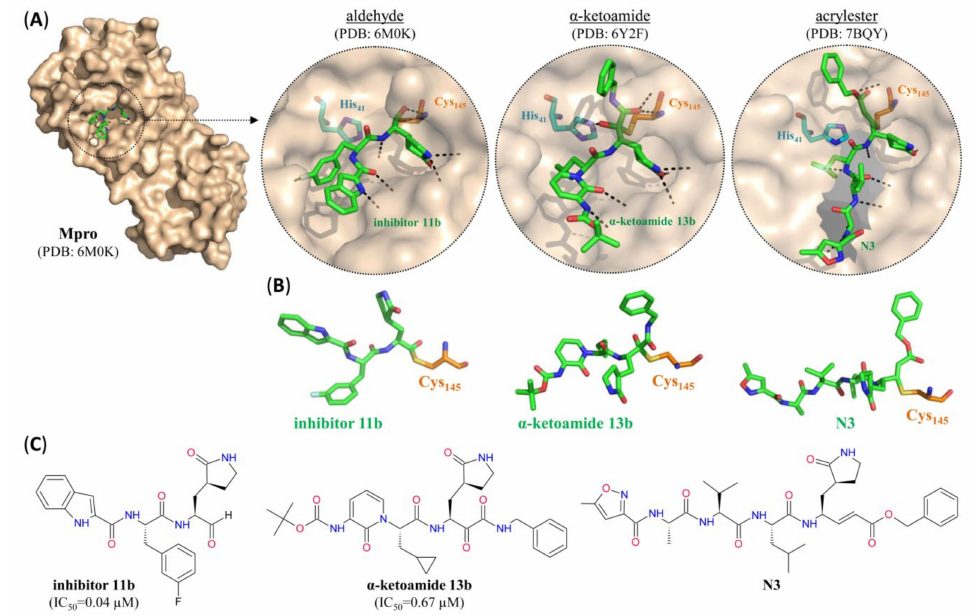
Figure 5. SARS-CoV-2 Mpro peptidomimetic inhibitors with di ff erent electrophilic warheads. ( A ) Surface representation of one protomer from the crystal structure of SARS-CoV-2 Mpro with the peptidomimetic inhibitor 11b (green) bound to the active site. Insets: close-up view of the active site after covalent modification by (from left to right) inhibitor 11b with an aldehyde warhead, α -ketoamide 13b with an α -ketoamide warhead or N3 with an acrylate warhead (green). Residues forming the catalytic dyad are indicated in turquoise (His 41 ) or orange (Cys 145 ) and hydrogen bonds are indicated by dashed black lines. ( B ) Stick representations of (from left to right) aldehyde inhibitor 11b, α -ketoamide 13b and acrylate N3 (green) covalently bound to the catalytic cysteine residue (orange). ( C ) Structure of (from left to right) aldehyde inhibitor 11b, α -ketoamide 13b and acrylate N3. For pharmacological properties see Table 2. For the structures of additional petidomimetic inhibitors with aldehyde or α -ketoamide warheads listed in Table 2, see Appendix A at the end of the